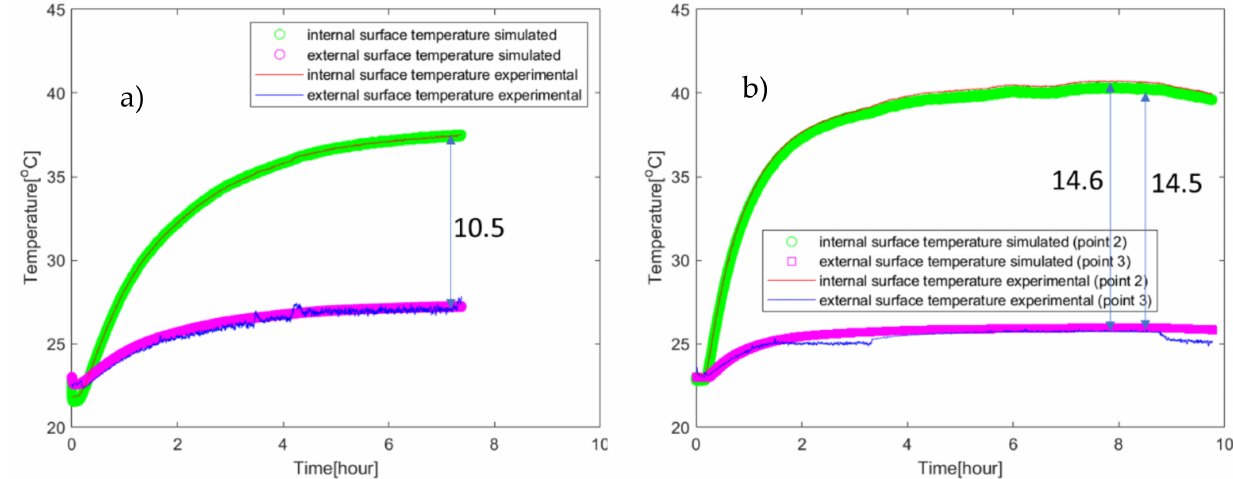
Figure 10. Temperature profile of configuration I from the simulation: ( a ) I-a with XPS thickness of 1 cm; ( b ) I-b with XPS thickness of 2